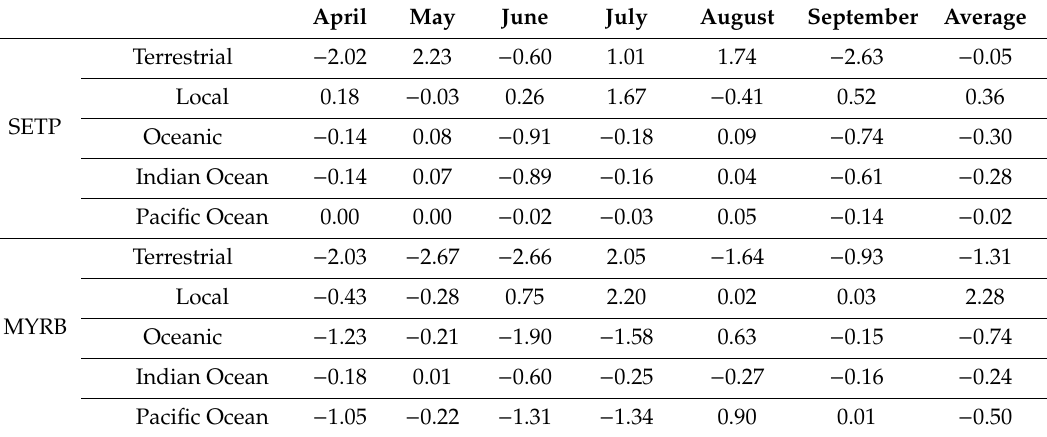
Table 4. Linear trends of monthly and wet season (April–September) averaged terrestrial and